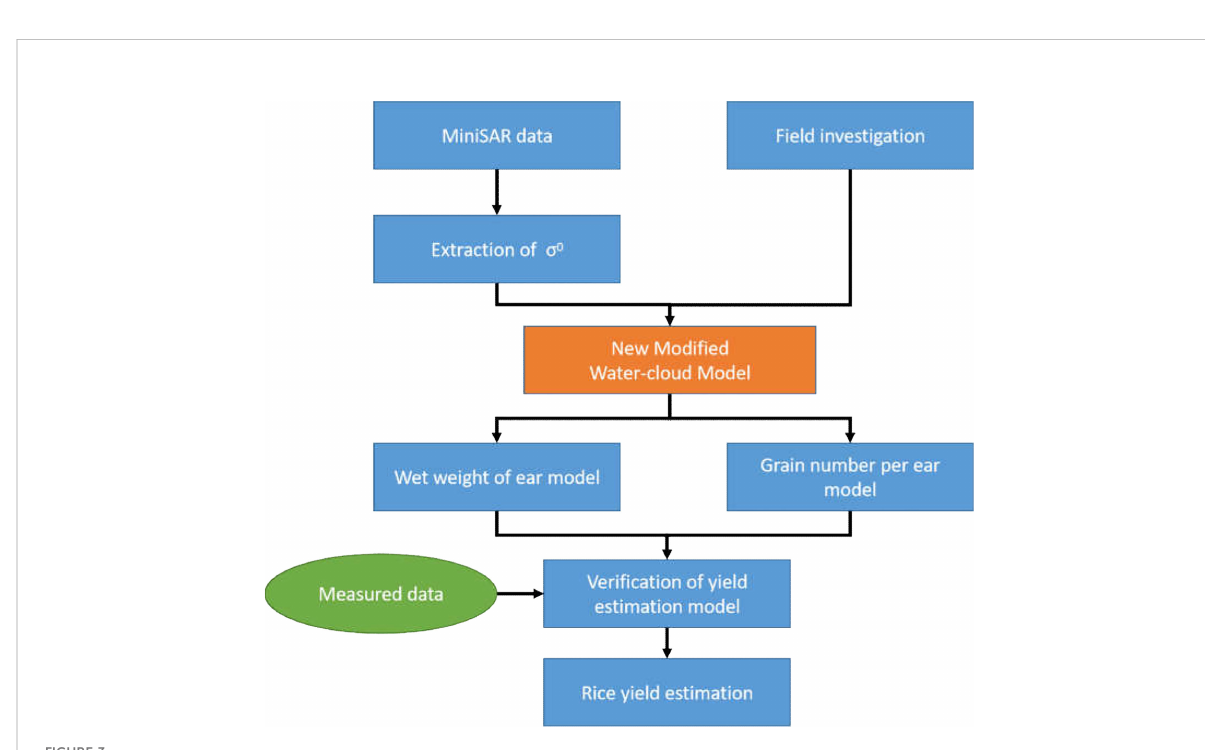
FIGURE 3 Overall technical fl ow